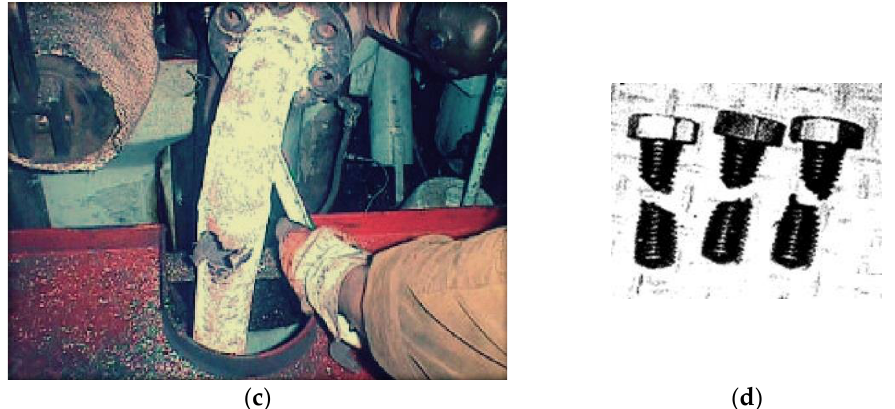
Figure 4. Examples of the effects of an explosion in a starting air manifold: ( a ) torn manifold main line(MAN, 2018); ( b ) torn manifold flap (MAN, 2018); ( c ) torn air supply line to the starting valve (Officer of the Watch, 2013); ( d ) bolts holding the starting valve head damaged by the explosion (modified based on Song & Sasaki, 2003).